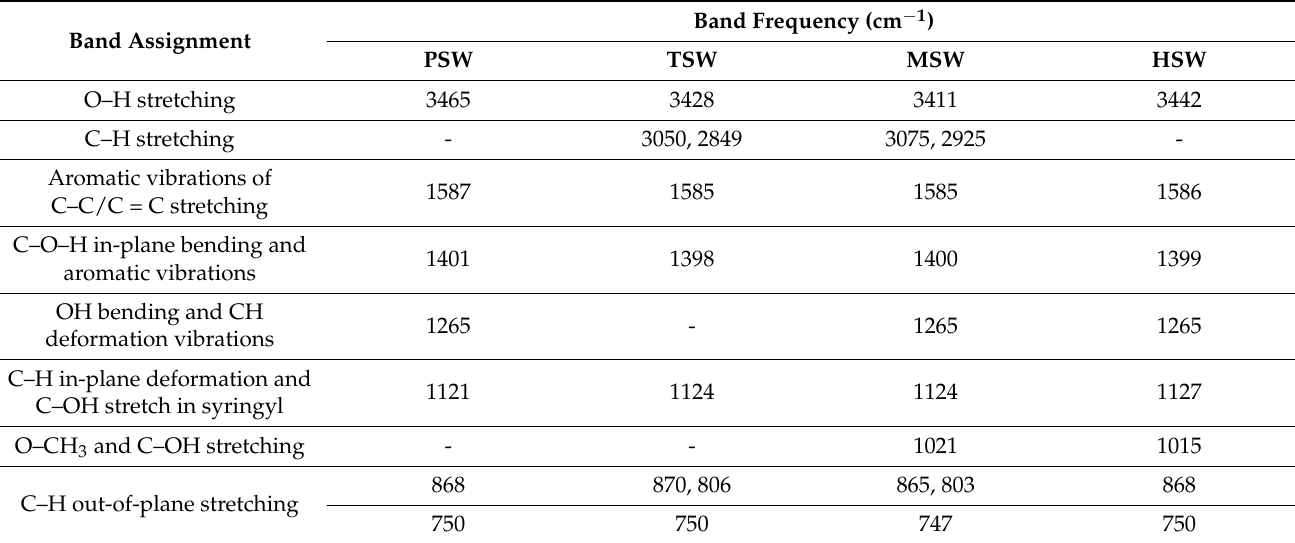
Figure 7. Infrared spectra of the different bio-chars. Table 3. FTIR band assignments spectra of different types of bio-chars at 375 ◦